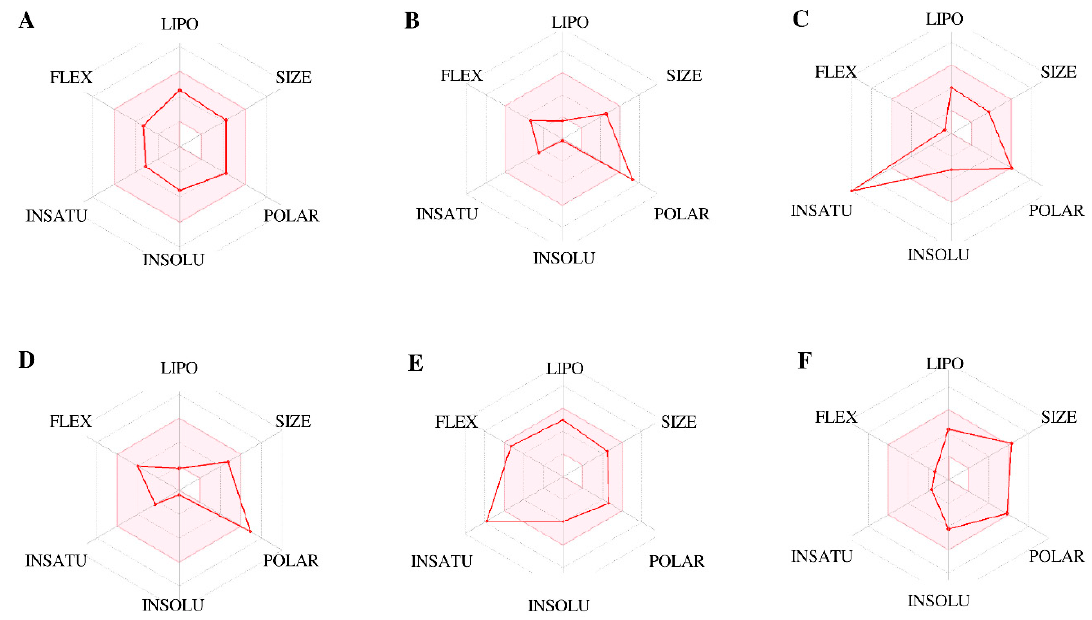
Figure 4. The physicochemical space for oral bioavailability. The bioavailability monitor supplies an initial evaluation of a molecule’s drug-likeness. The colorful region represents the appropriate physic- ochemical environment for oral bioavailability of LCI ( A ), geniposidic acid ( B ), quercetin ( C ), genipo- side ( D ), curcumin ( E ), and withanolide C ( F ). Parameters: POLAR (polarity, 20 Å 2 < TPSA < 130 Å 2 ), LIPO (lipophilicity, − 0.7 < XLOGP3 < +5), INSOLU (insolubility, 0 < Log S (ESOL) < 6), SIZE (molec- ular size, 150 g/mol < MW < 500 g/mol), INSATU (unsaturation, 0.25 < Fraction Csp3 < 1), and FLEX (flexibility, 0 < Num. rotatable bonds <